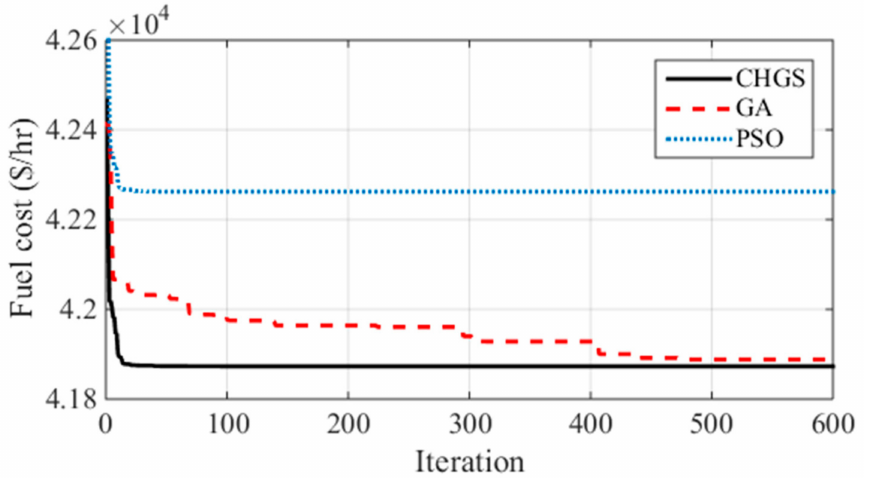
Figure 3. Simulated cost function convergence in case of the 57-bus system.